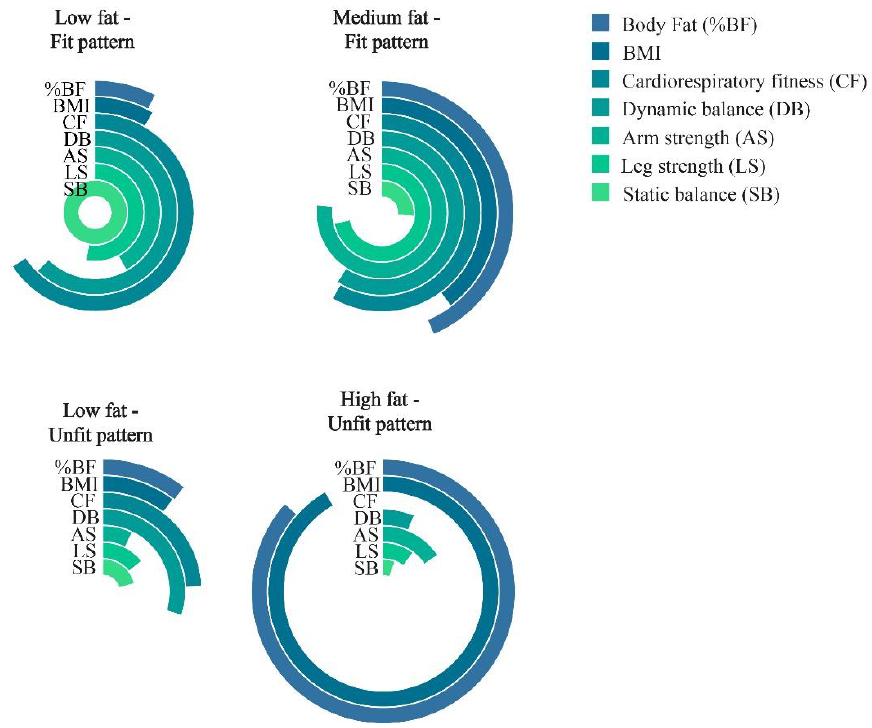
Figure 1. Physical fitness and body fat z-scores, adjusted by sex and age. Note: The z-scores were reconverted into units from 0 to 1 to create this figure.